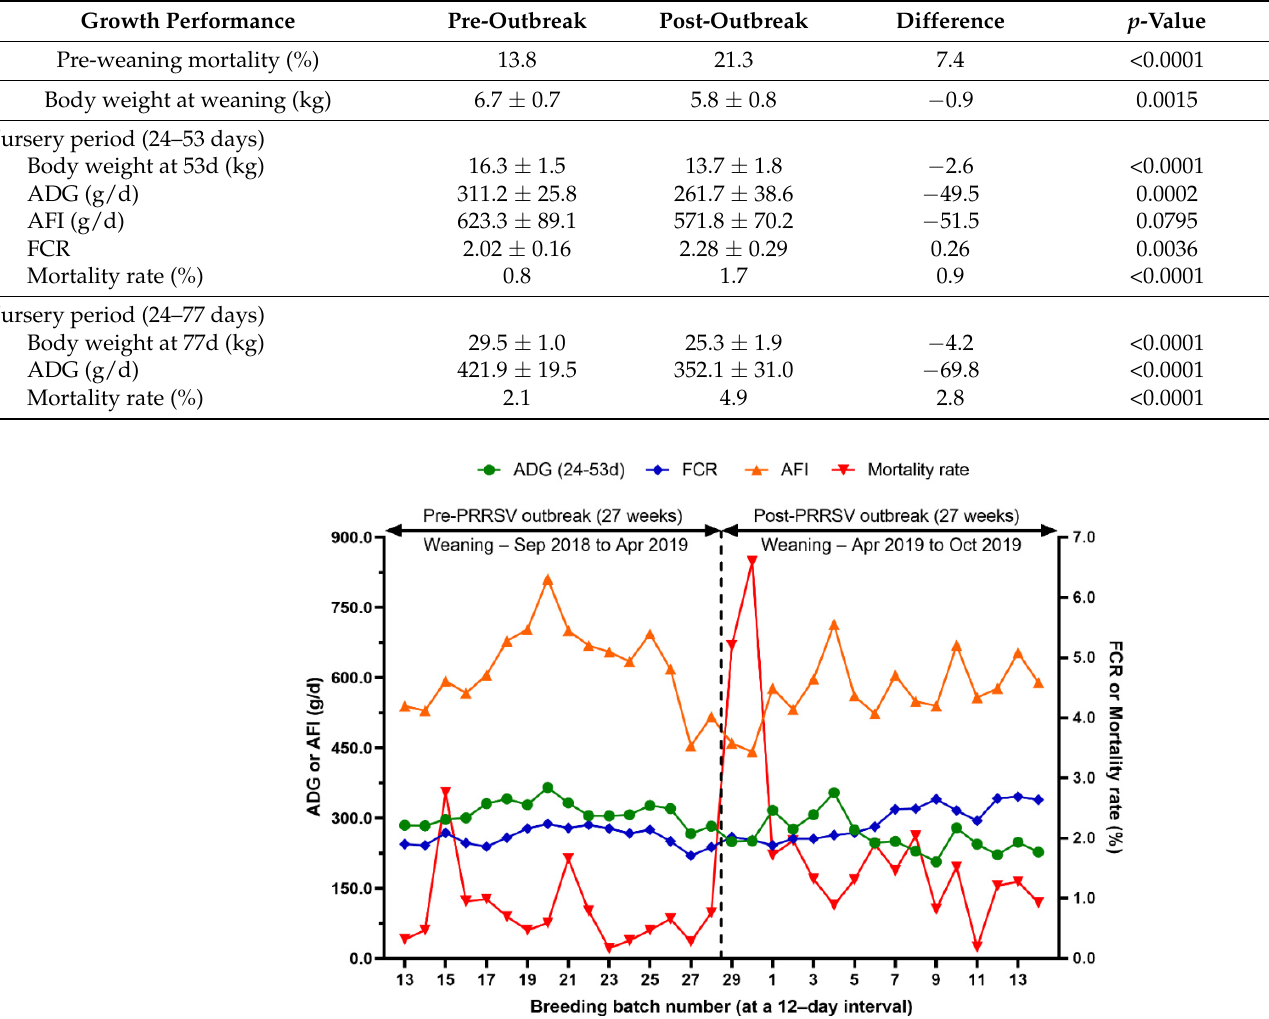
Table 3. The economic impact of PRRS on the breeding-farrowing production phase. Variable